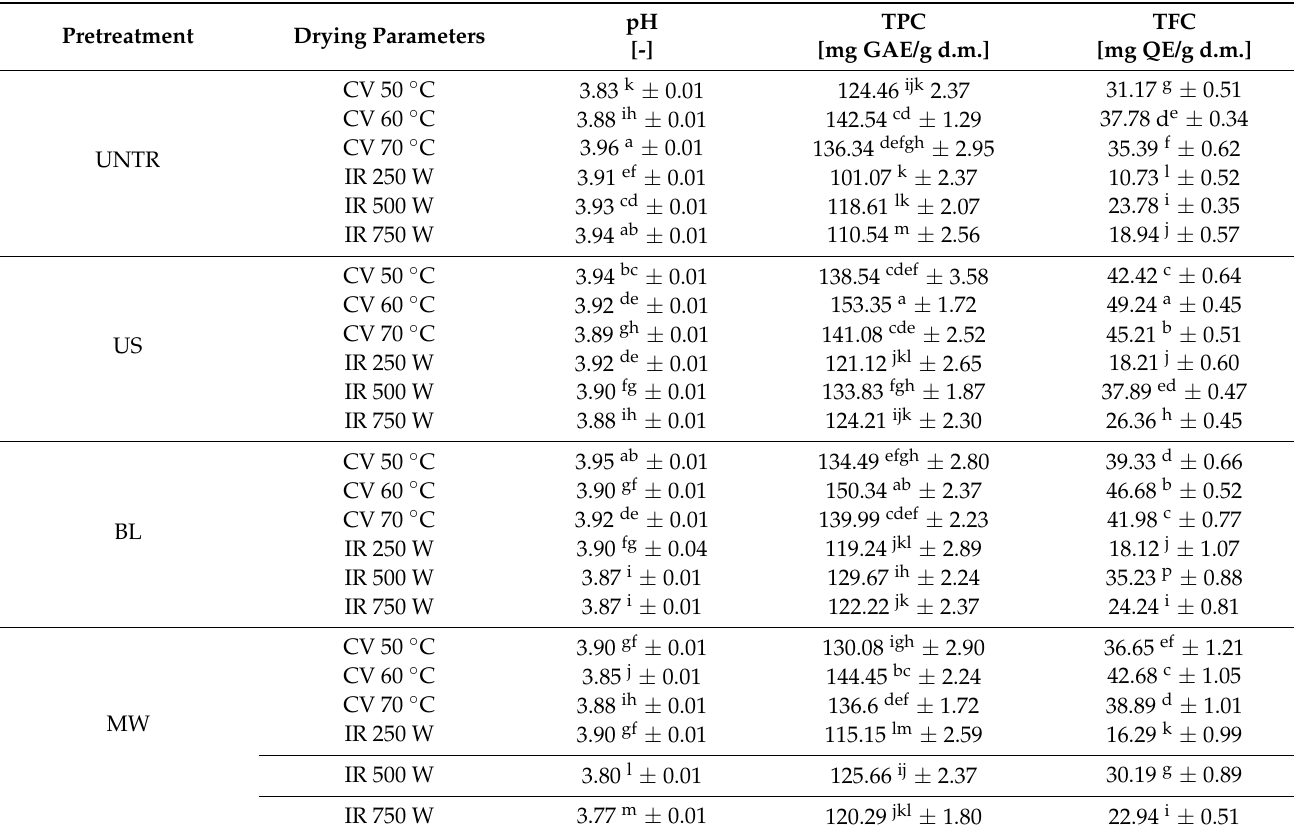
Table 4. Results of time, effective moisture diffusivity coefficient ( D eff ), specific energy consumption (SEC), and